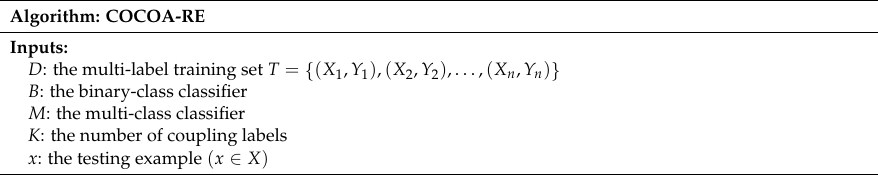
Table 1. The pseudo-code of (COCOA-RE). COCOA-RE: a regularized ensemble approach integrated into multi-class classification process of COCOA; COCOA: Cross-Coupling